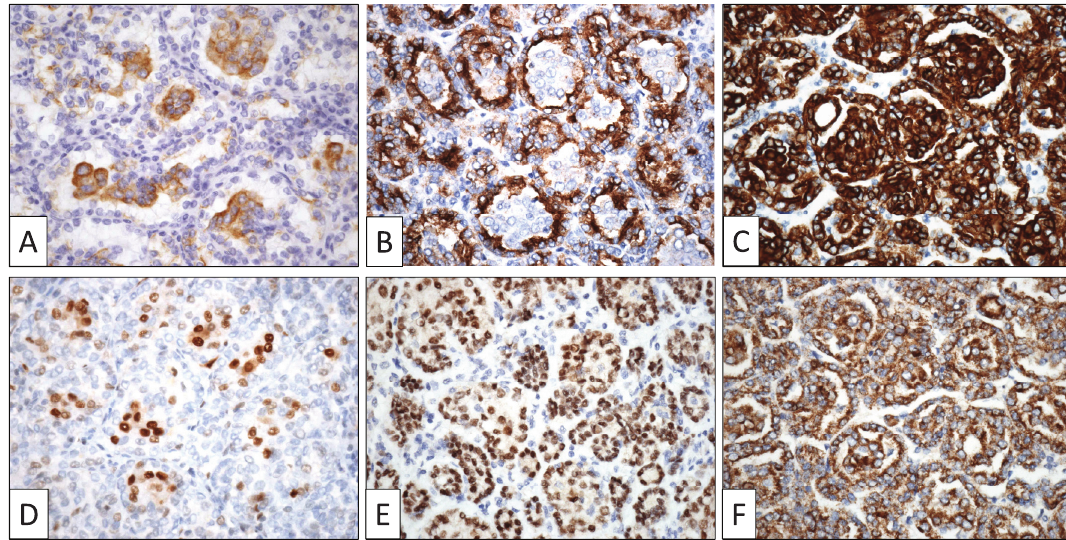
Figure 4. Immunohistochemical study with 34 β E12 ( A ), RCC marker ( B ), CK7 ( C ), cyclin D1 ( D ), PAX-8 ( E ) and AMACR ( F ). Noteworthy, 34 β E12 and cyclin D1 selectively immunostain the central squamoid cell groups and, conversely, RCC marker does it only in peripheral alveolar cells. CK7, PAX-8 and AMACR immunostain both cell types